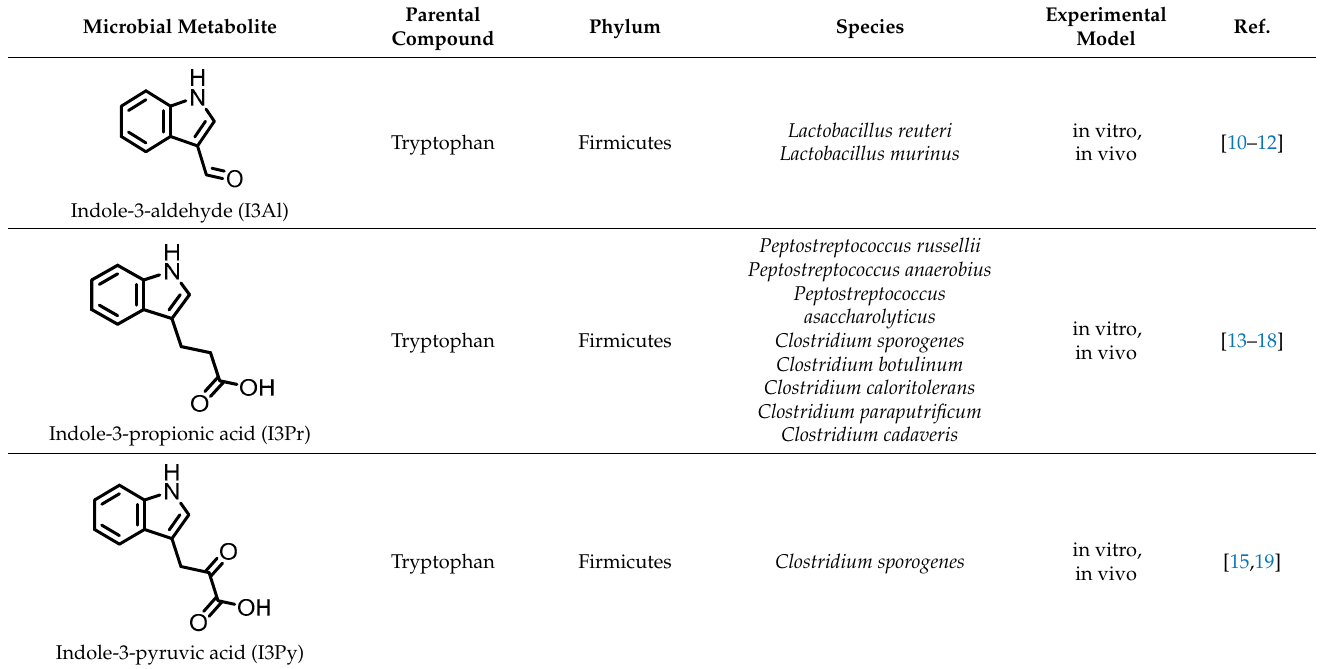
Table 1. Overview of metabolites, bacterial species currently known to produce these metabolites, and experimental models used to assess anti-IBD effects.